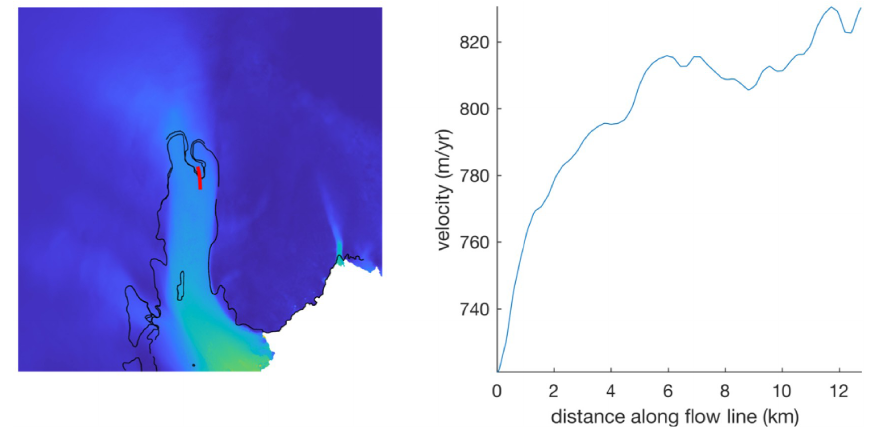
Figure A1. Velocity map of the Totten Glacier from ITS_LIVE (left) used to explain the concept of velocity overestimation caused by acceleration (right): “Over 16 years, that parcel of ice travels about 13km downstream (red path). It begins at a velocity of about 720m/yr, and in the first 8 months it travels at an average rate very close to 720m/yr. But then the ice picks up speed as it moves downstream, so in the first 10 years it does not travel just 7200m – it actually travels about 7900m, or an average speed of 790m/yr” (Chad A. Greene, personal communication,